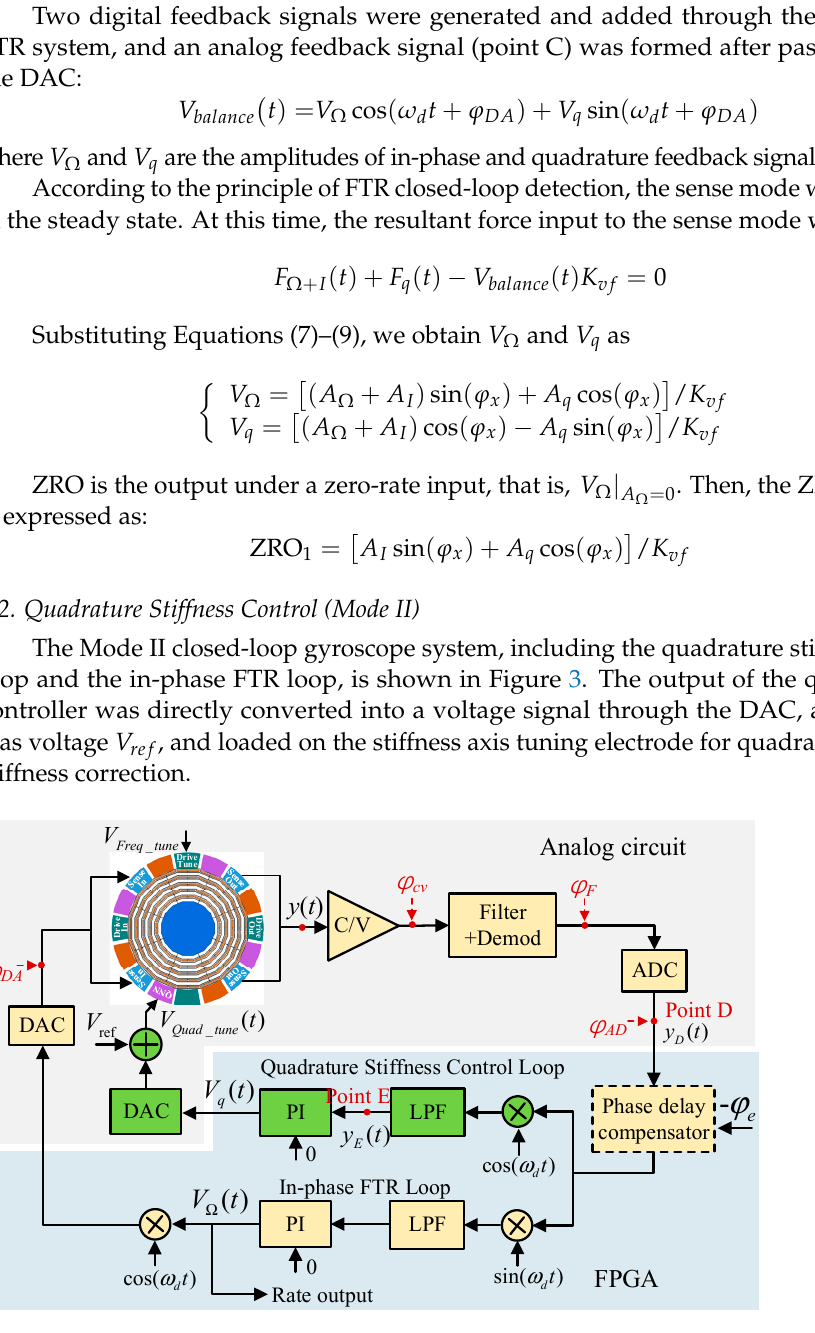
Figure 3. The control scheme of the Mode II closed-loop gyroscope system.